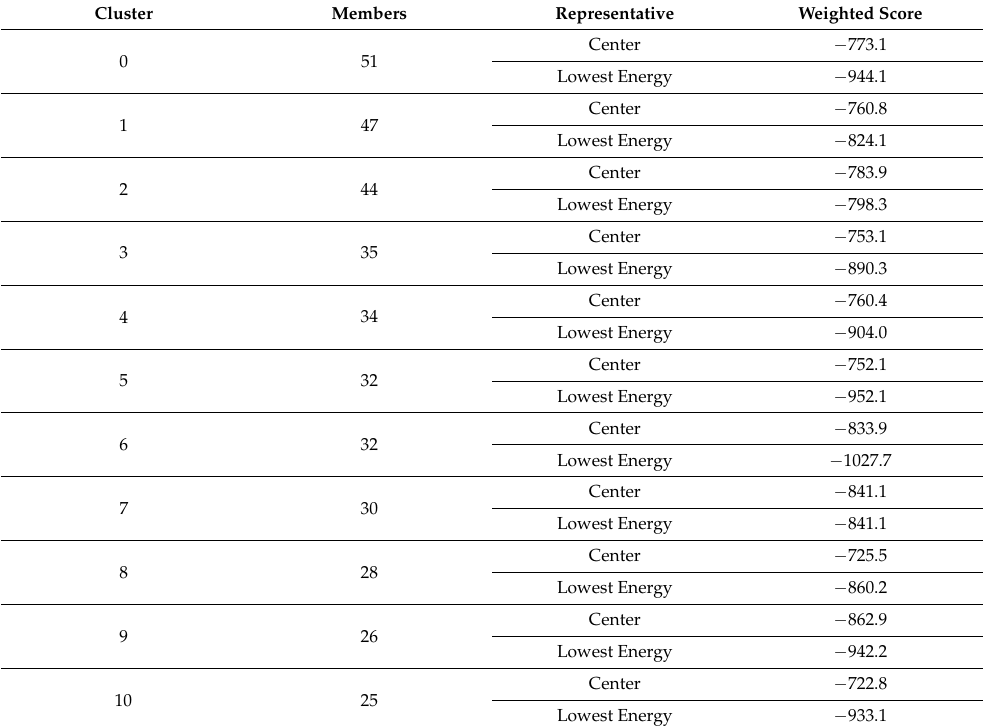
Table 6. Docking score of vaccine-MHC-I solutions.